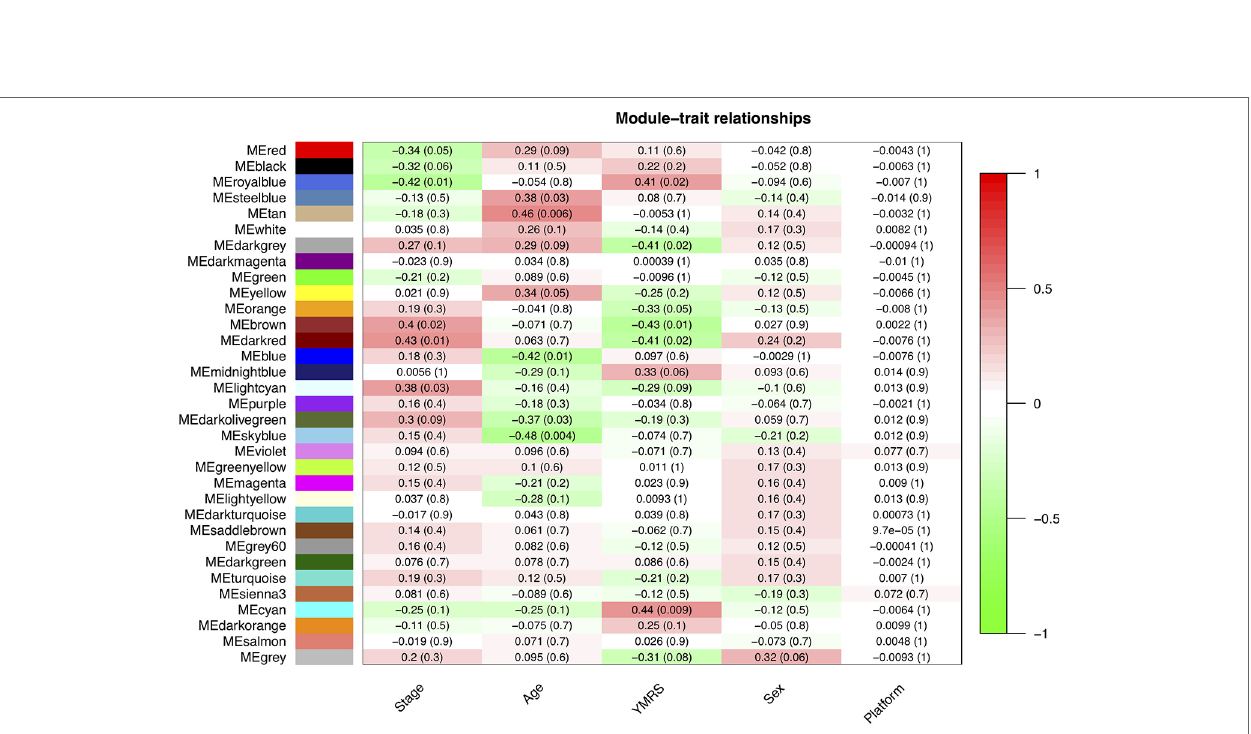
FIGURE 4 | The relationship between 33 modules with clinical traits. The figure was constructed under WGCNA analysis. The correlations between modules and clinical traits were performed with Pearson’s correlation. YMRS: Young Mania Rating Scale; Platform: different array types.